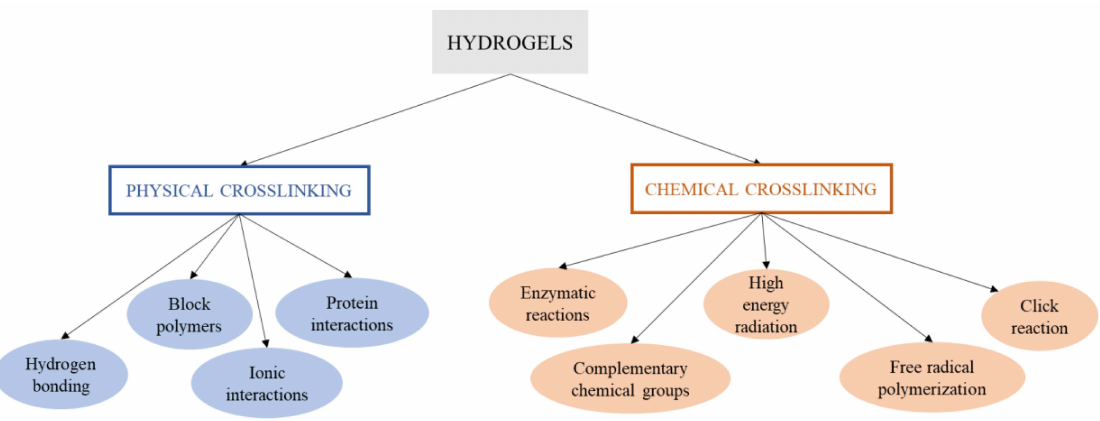
Figure 3. Schematic overview of the different physical and chemical cross-linking methods of synthesis of